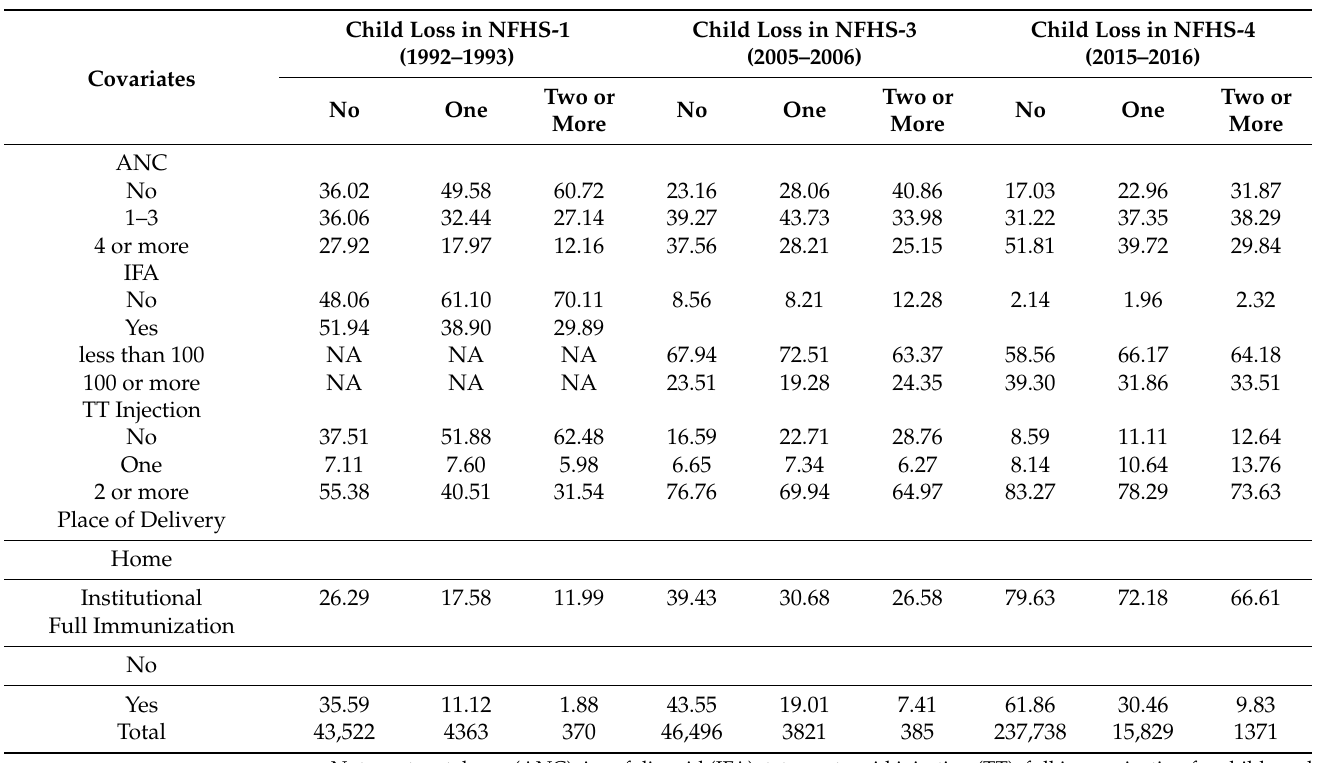
Table 9. Utilization of health services of women with no child loss, women with exactly one child loss, and women with loss of two or more children, India,